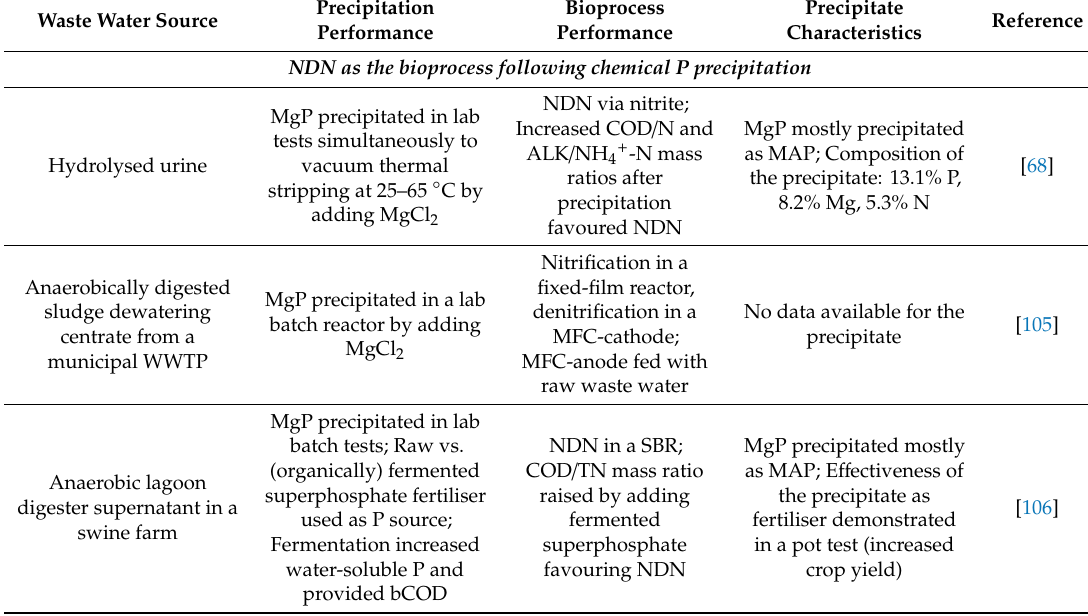
Table 2. Summary of experiences integrating chemical precipitation aimed at P recovery, followed by biological N oxidation, or removal (upstream precipitation). More details are given as Supplementary